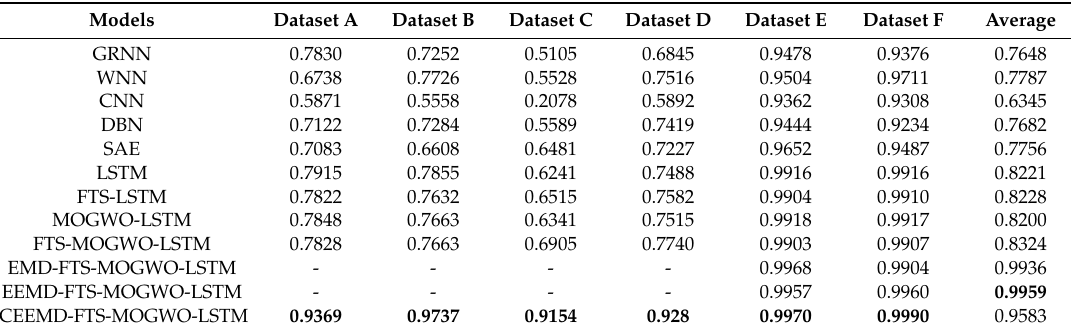
Table 11. Results for the Pearson’s